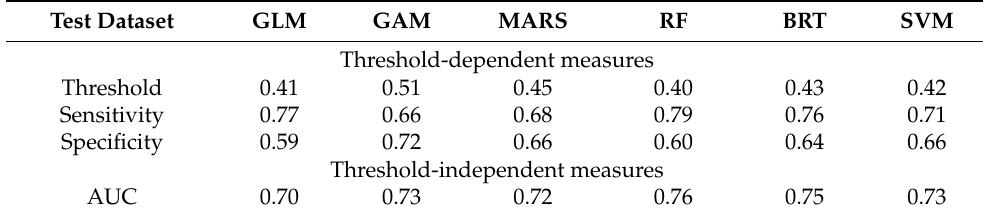
Table 3. Model evaluation of six modelling techniques predicting the distribution of anchovy eggs in the test